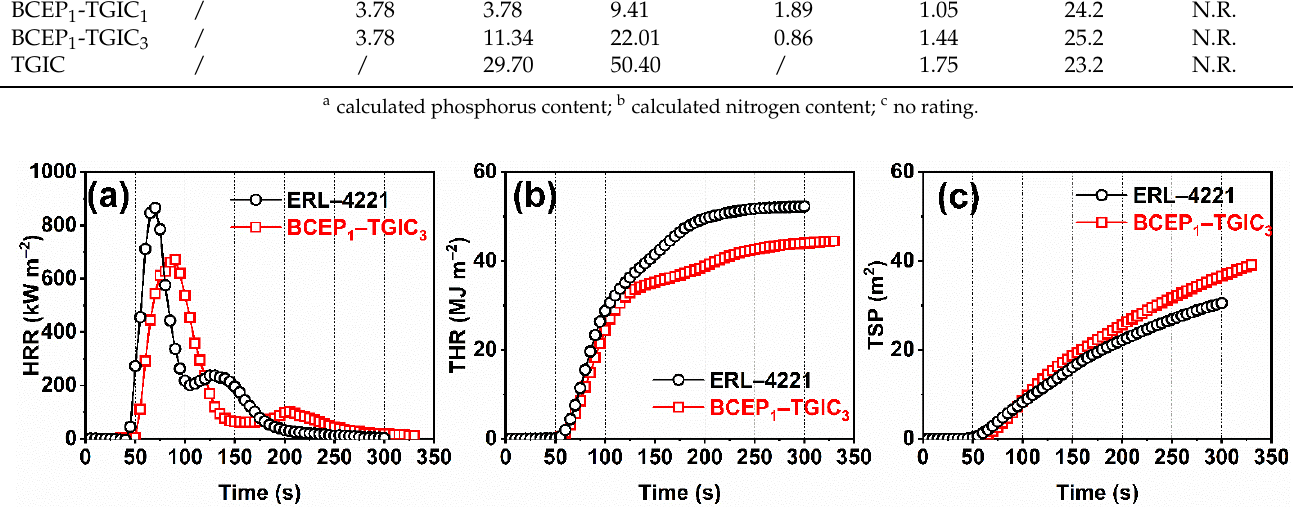
Table 2. Formula and flame retardancy test results of the epoxy system.